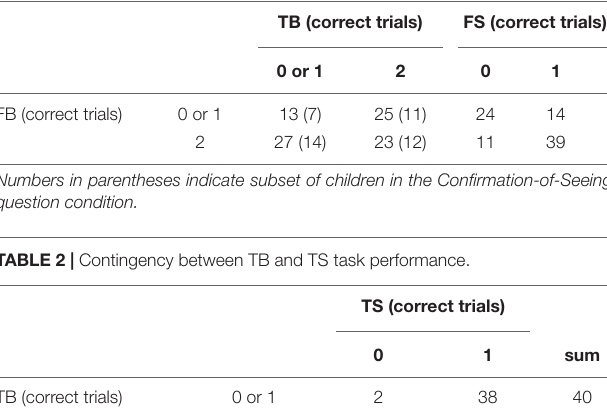
TABLE 1 | Contingency between FB and TB and FS task performance.